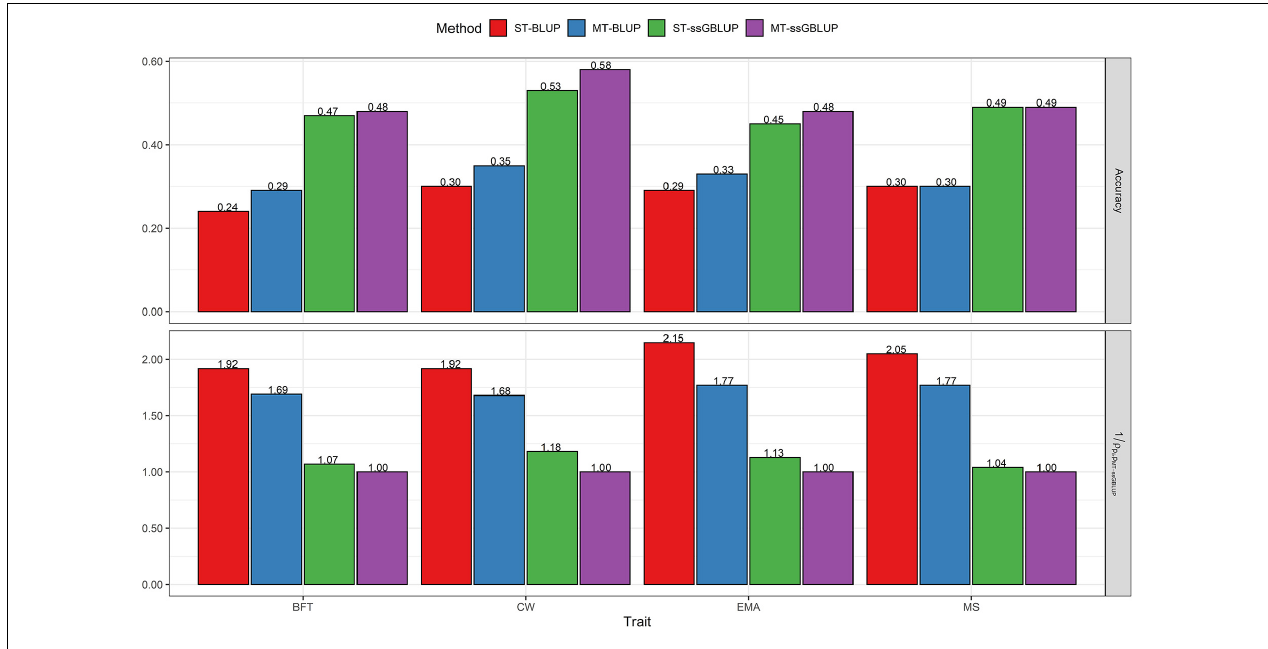
: the relative pi , pMT − ssGBLUP